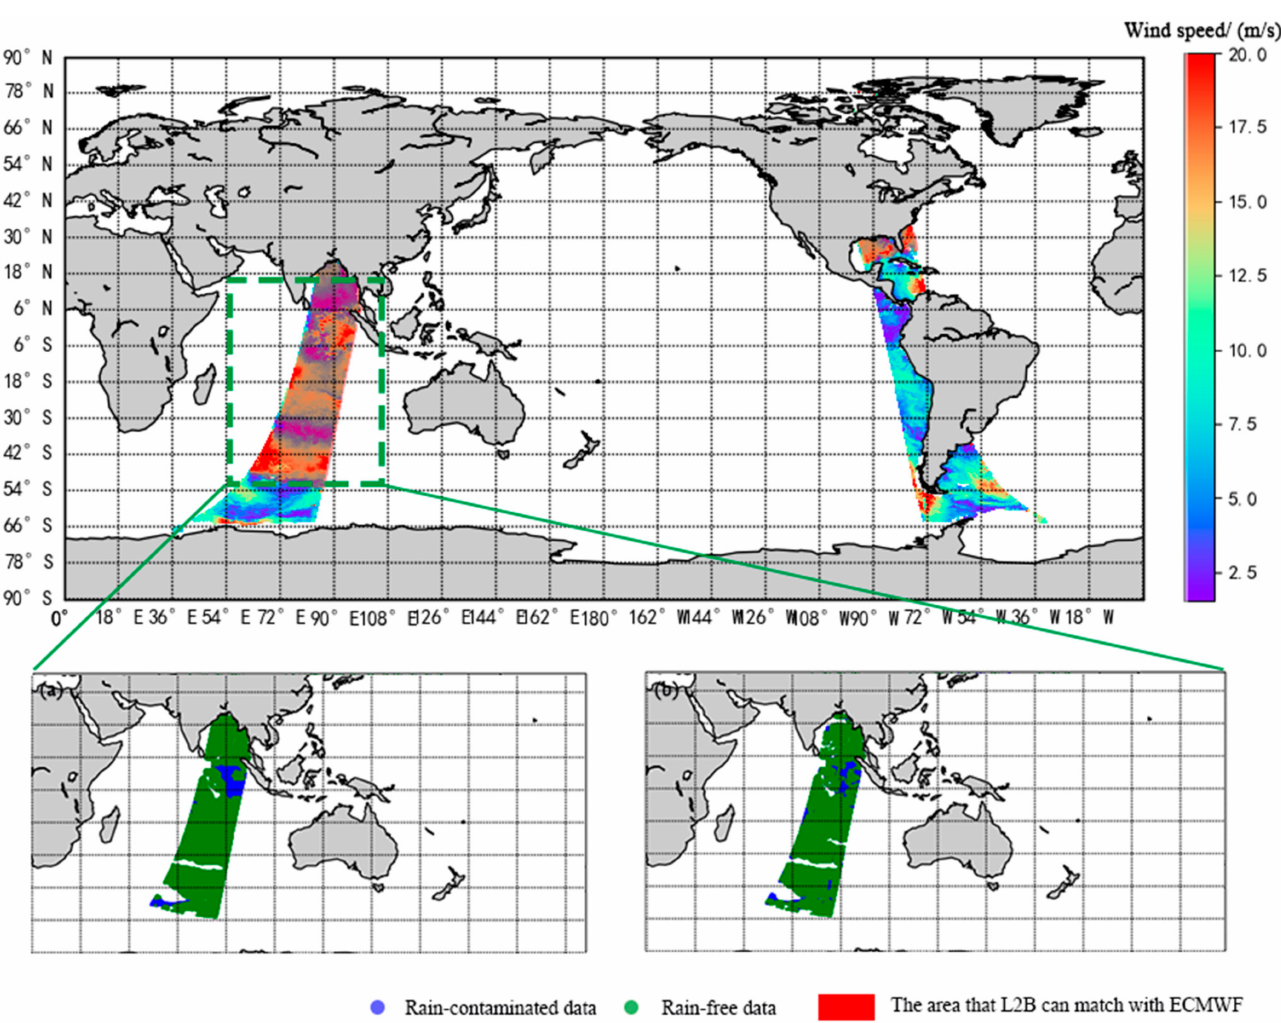
Figure 9. Situation of rain identification using H2A_SM2B20130404_07609 data. ( a ) Identification result of ECMWF; ( b ) identification result of